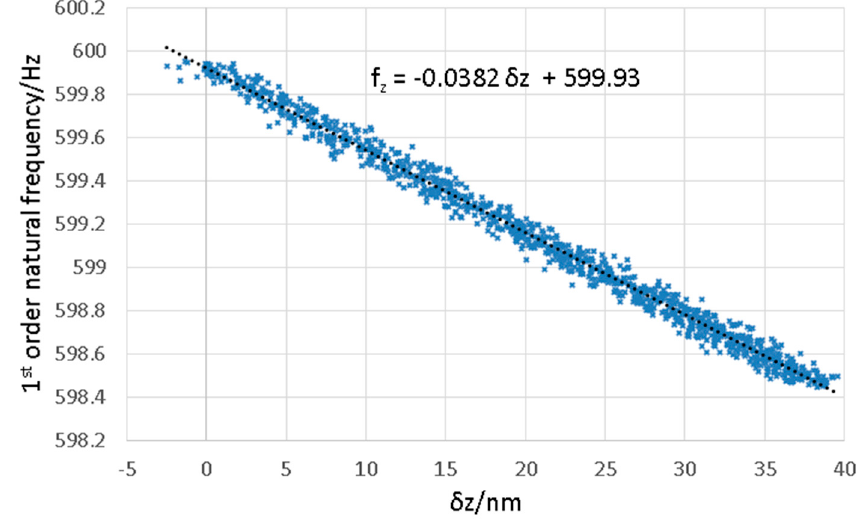
Figure 16. Plot showing the sensitivity of vertical frequency with respect to the displacement at the probe tip in the z direction.